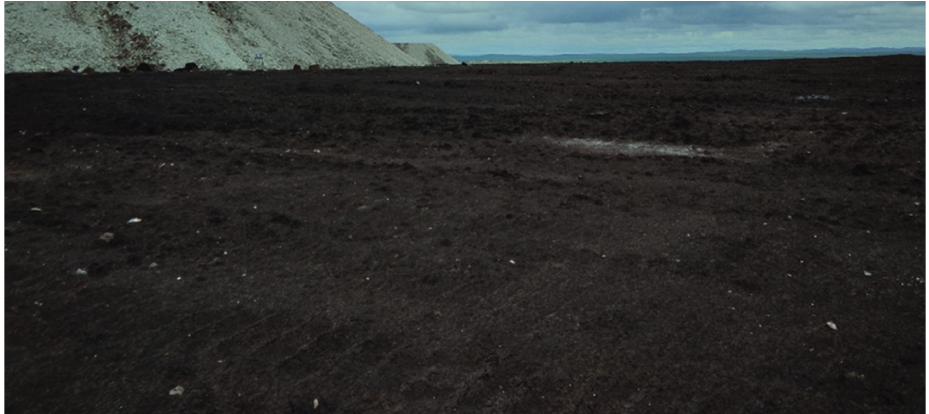
Figure 2: Water-blocking